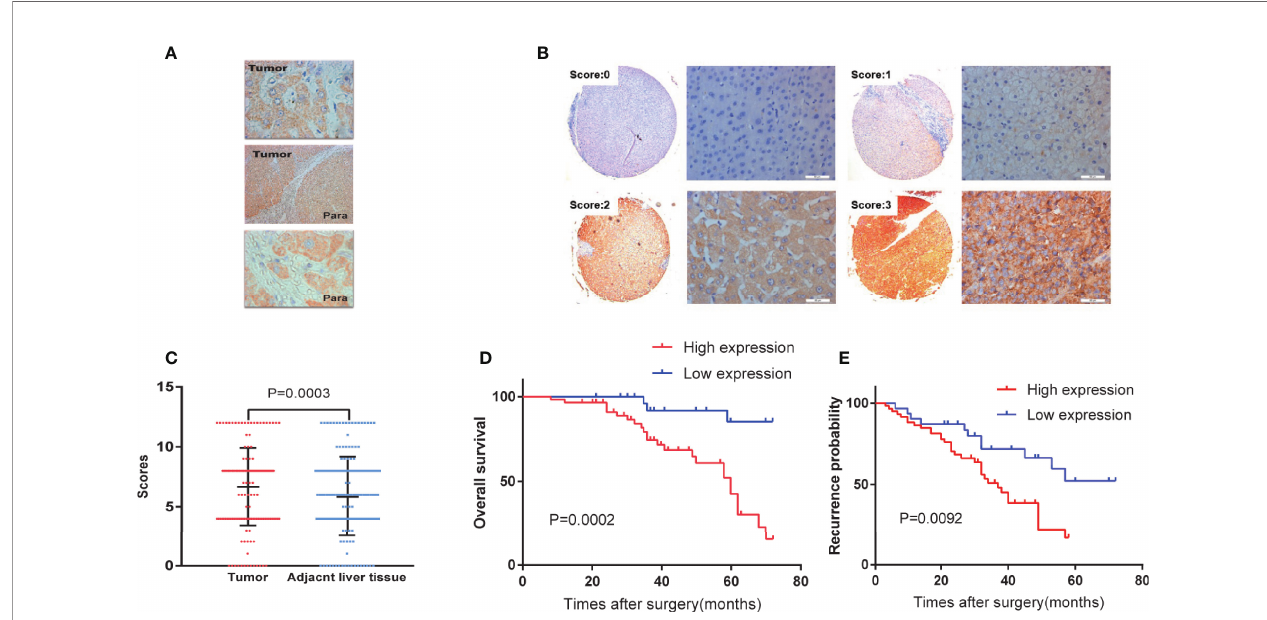
FIGURE 3 | Analysis of SMPDL3A expression in human HCC tissues and survivals of HCC patients. (A) Expression of SMPDL3A in human HCC tissues and paracancerous tissues. SMPDL3A was mainly expressed in the nucleus or cytoplasm(upper tumor ×400, middle tumor and para ×40,down para ×400). (B) Staining scores of SMPDL3A protein expression in HCC tissue samples and surrounding noncancerous tissues. The staining score ranged from 0 to 3, with 0 for no staining, 1 for weak staining, 2 for moderate staining, and 3 for strong staining(×40, ×400). (C) The immunostaining score of SMDPL3A in 180 pairs of human HCC tissues and paracancerous tissues. Among the 180 pairs of tissue sections in this study, the difference in SMPDL3A expression in HCC tissues and the tumor-adjacent liver tissues were statistically signi fi cant (6.672±3.232 vs. 5.850±3.333, P = 0.0003). (D) Kaplan-Meier analysis of overall survival outcomes. The overall survival rates of patients in the high-SMPDL3A expression group at postoperative 1, 3, and 5 years(s) (96.61%,74.47% and 42.70%) were signi fi cantly lower than those in the low- SMPDL3A expression group (100%,91.83% and 85.27%, P=0.0002). (E) Kaplan-Meier analysis of disease-free survival outcomes. The 1-, 3-, and 5-year tumor-free survival rates (86.44%,50.94% and 16.56%) of the patients in the high-SMPDL3A expression group were signi fi cantly lower than those in the high-SMPDL3A expression group (90.32%,71.85% and 52.23%, P = 0.0092) .